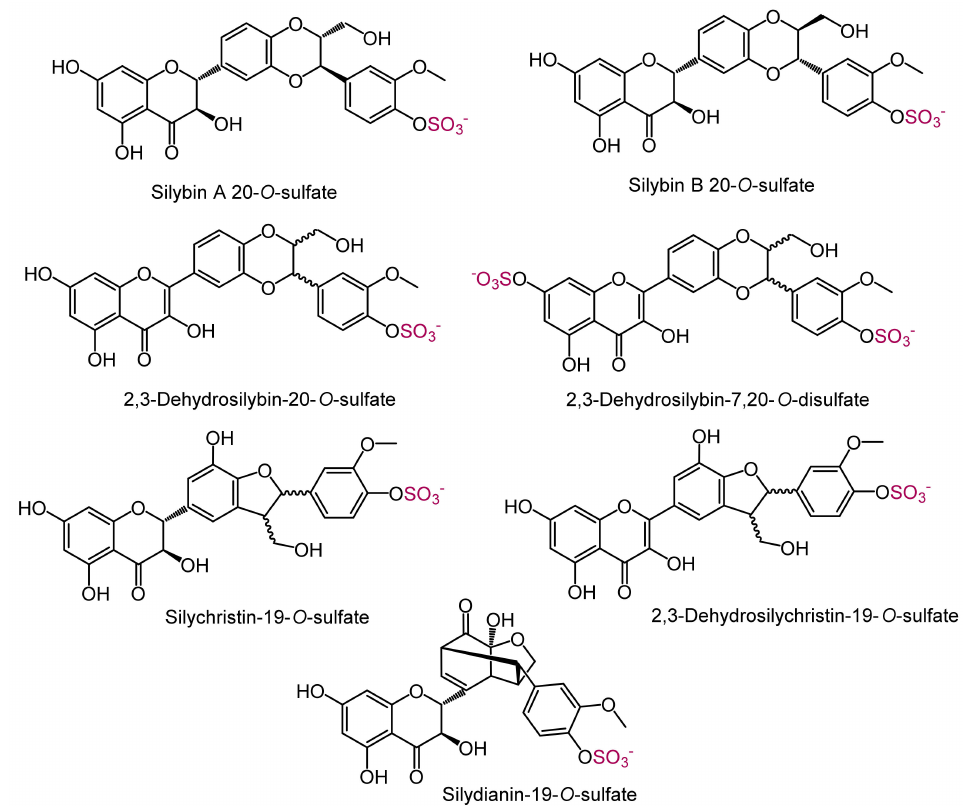
Figure 4. Isolated sulfated products. The sulfate groups are highlighted in red.